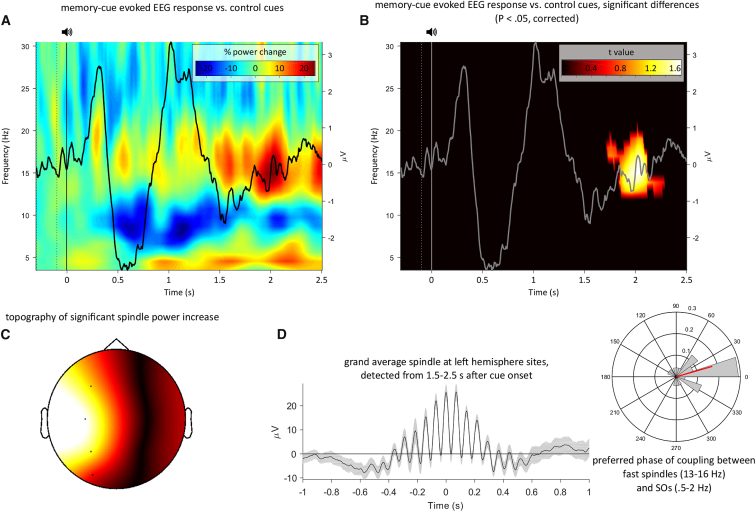
Time-Frequency Representation(A) Time-frequency representation (TFR) difference map of responses elicited by old memory cues versus new control adjectives, with the corresponding ERP for old cues superimposed.(B) Same as (A) but after statistical thresholding (p < 0.05, corrected). Note the significant increase in fast spindle power (13–16 Hz) from ∼1.7 to 2.3 s post cue onset.(C) Topography of the resulting cluster, revealing left-hemisphere specificity of the effect.(D) Left: Grand average (±SEM) of discrete spindle events detected from 1.5 to 2.5 s after onset of old memory cues at left-hemisphere sites. Right: Histogram of participants’ corresponding SO-spindle modulation phases (mean direction = 15°, shown in red). Direct comparison of discrete spindles for old memory cues versus new control stimuli is shown in Figure S3.